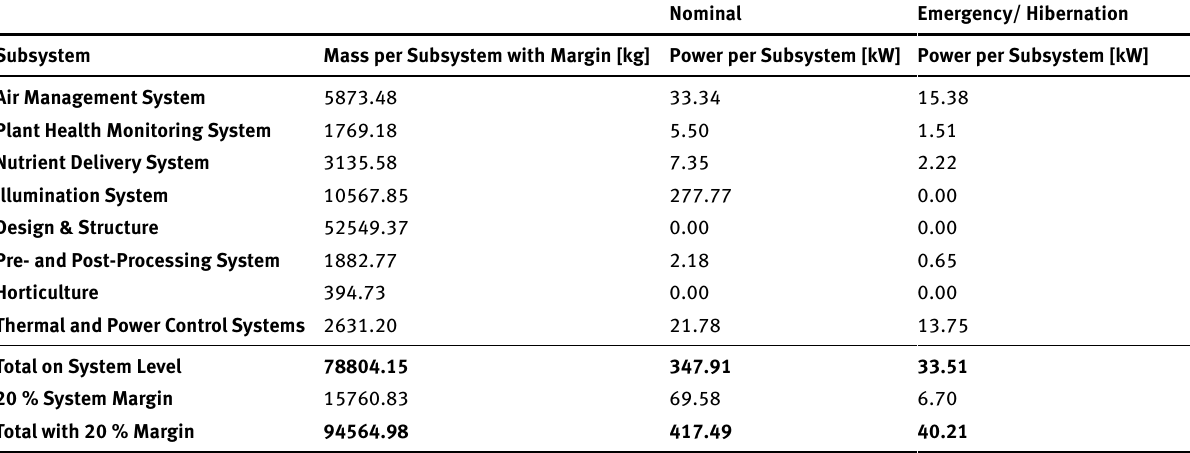
Table 6: Overview of the system mass budgets and the power budgets including system